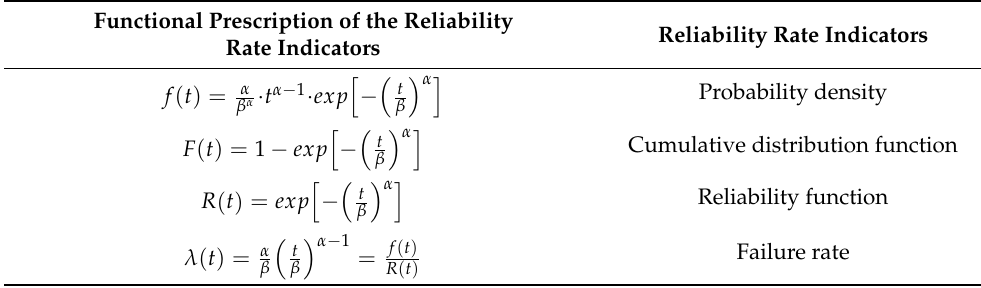
Table 1. The functional prescriptions of the reliability rate